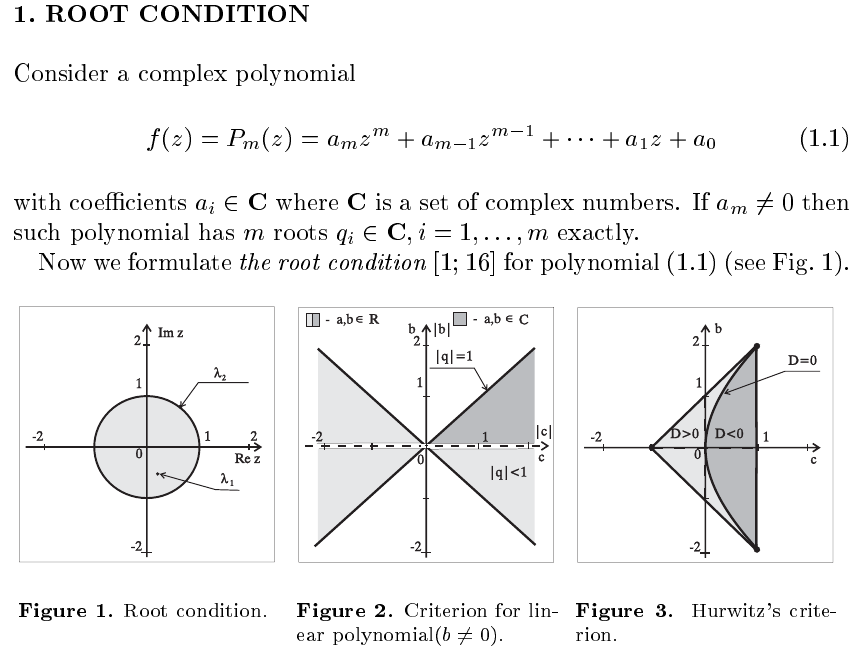
earpolynomial(cid:9)b(cid:1)(cid:17)(cid:18)(cid:10)(cid:1)